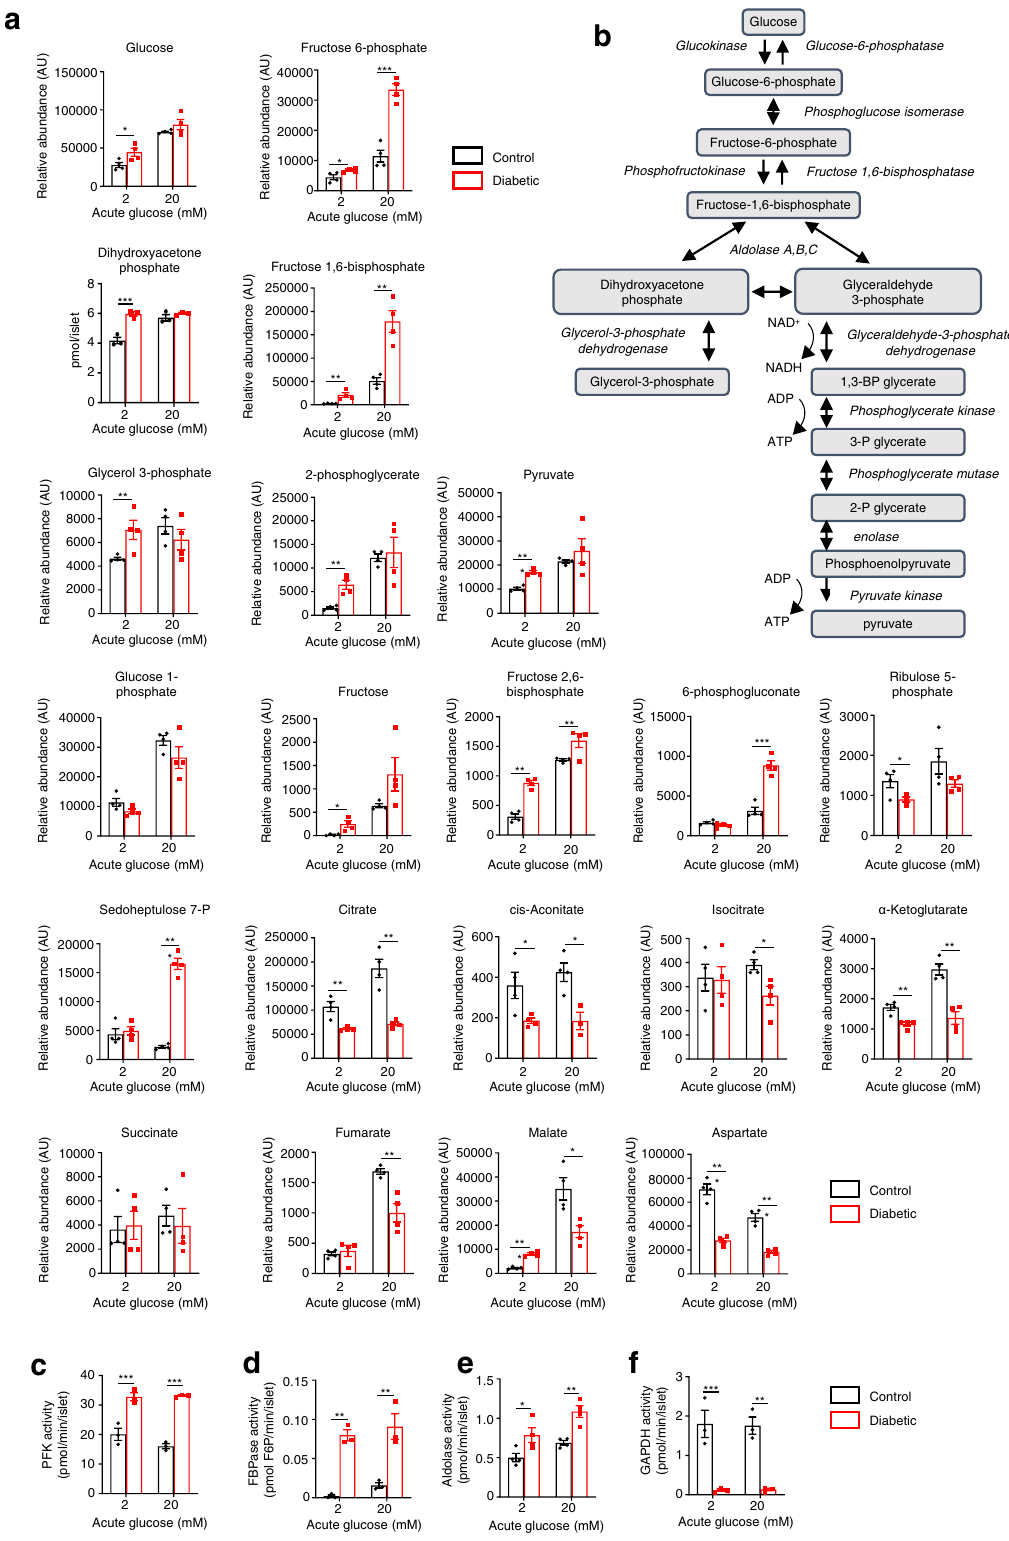
Fig.3|Changesinmetaboliteabundanceinducedbychronichyperglycaemia. a Abundances of selected glycolytic, pentose phosphate pathway and TCA cycle metabolites in control (black bars) and diabetic (red bars) islets stimulated with 2mM or 20mM glucose.( n =4 animals/genotype). Metabolites were measured by mass spectrometry, except for DHAP which was measured with a fl uorimetric assay. b Schematicofglycolysis. c – f Activityoftheindicatedglycolyticenzymesin control (black) and diabetic (red) islets stimulated with 2 or 20mM